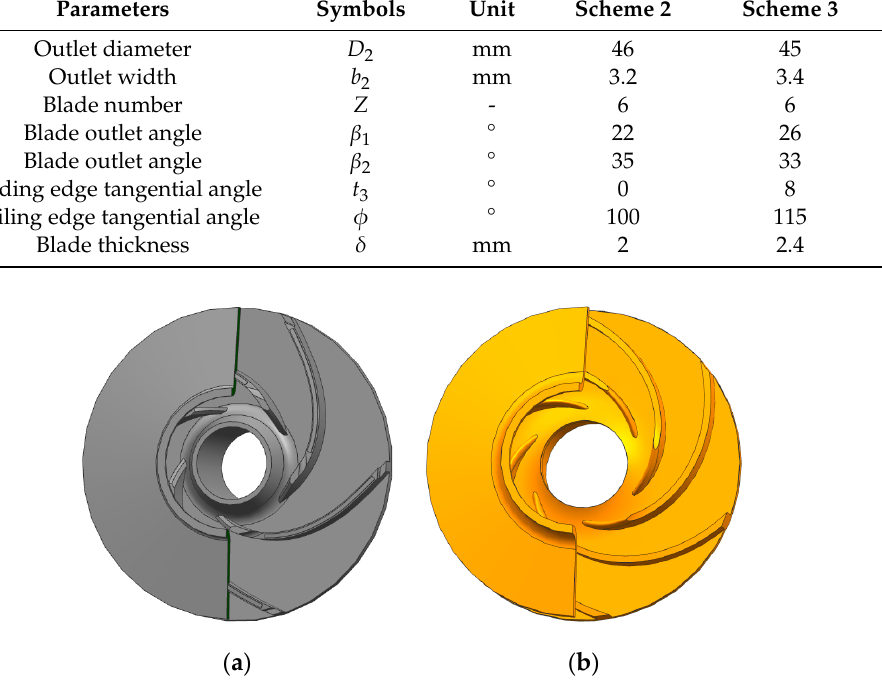
Figure 17. Comparison of impeller model: ( a ) scheme 1; ( b ) scheme 3.